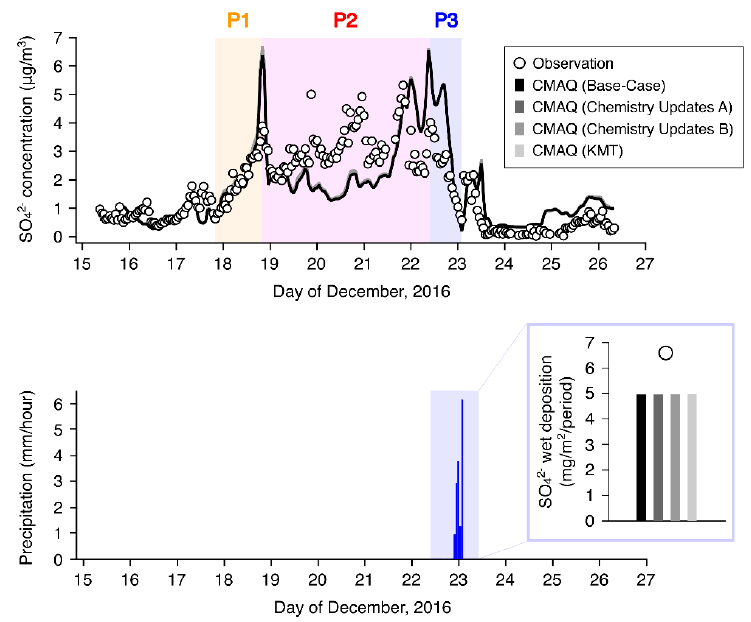
Figure 4. Temporal variation of ( top ) hourly observed and modelled ambient concentrations of SO 42 , and ( bottom ) hourly modelled precipitation at the Tokyo site for domain 4. The inset in bottom figure is the daily accumulated SO 42– wet deposition for the observed and modelled results.